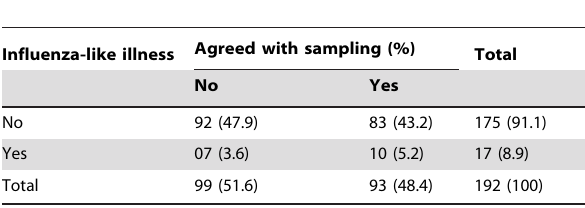
Table 2. Influenza-like illnesses in HCWs according to acceptance of nasal wash